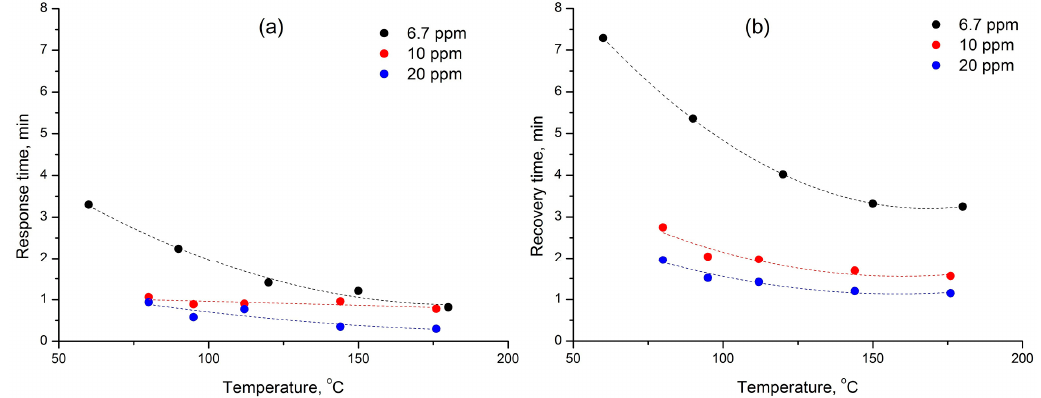
Figure 11. Values of response ( a ) and recovery ( b ) time as a function of temperature at 0% r.h.